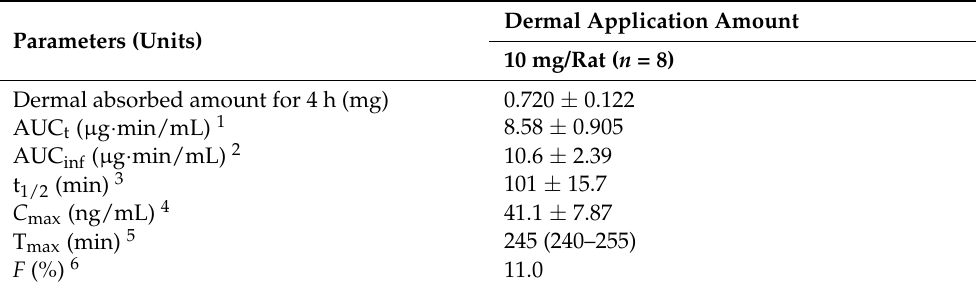
Figure 5. Mean plasma concentration–time profiles of benzisothiazolinone after a dermal application of 10 mg on rats ( n = 8). Vertical bars represent the SD. Table 5. Pharmacokinetic parameters (mean ± SD) of benzisothiazolinone (BIT) after the dermal application of BIT on rats.